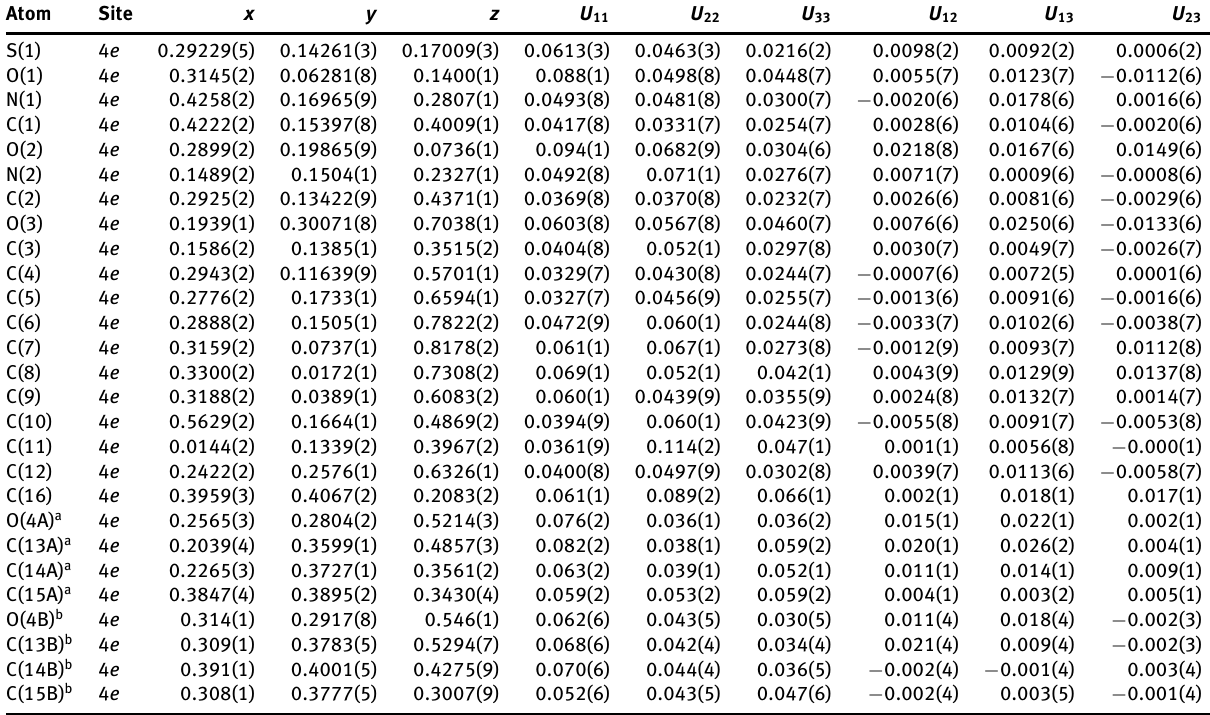
Table 3: Atomic displacement parameters (Å 2